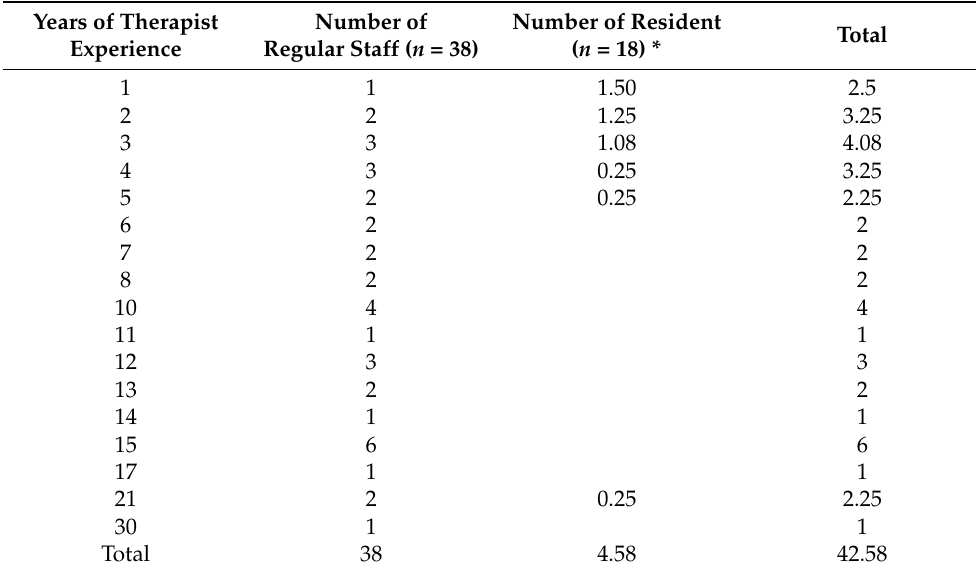
Table 1. Distribution of years of therapist experience among regular staff and